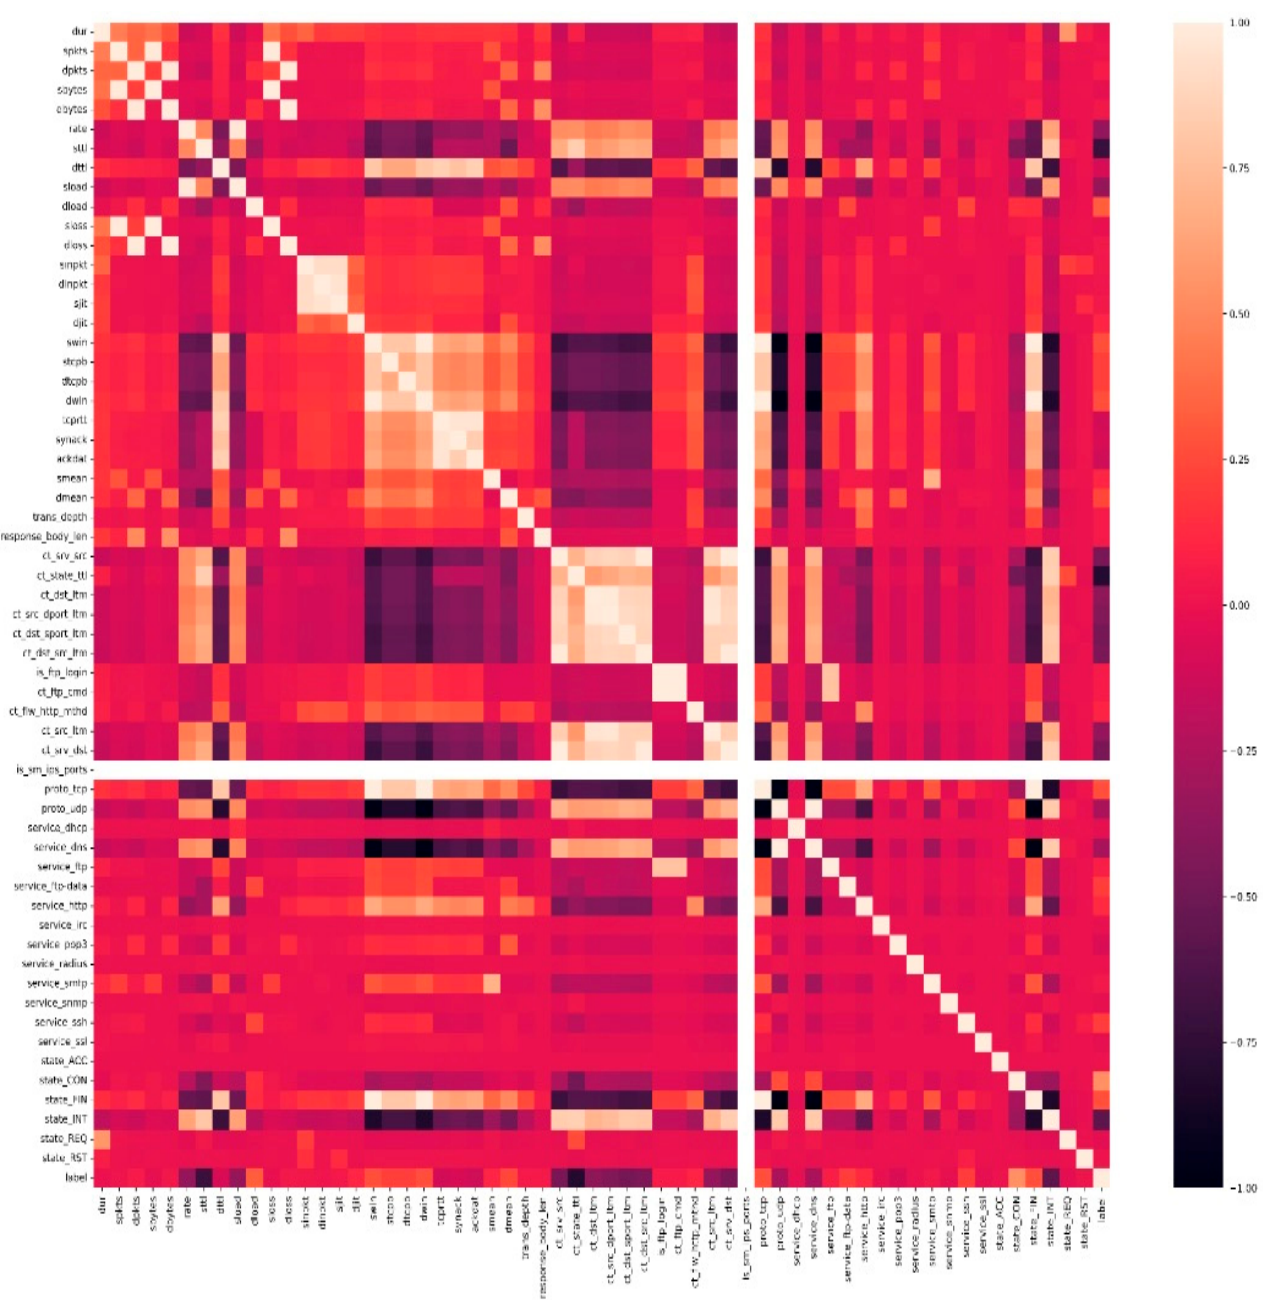
Figure 5. Correlation matrix of the binary class dataset. By setting a threshold value of >0.3, 15 columns of features from the total of 61 columns are extracted.